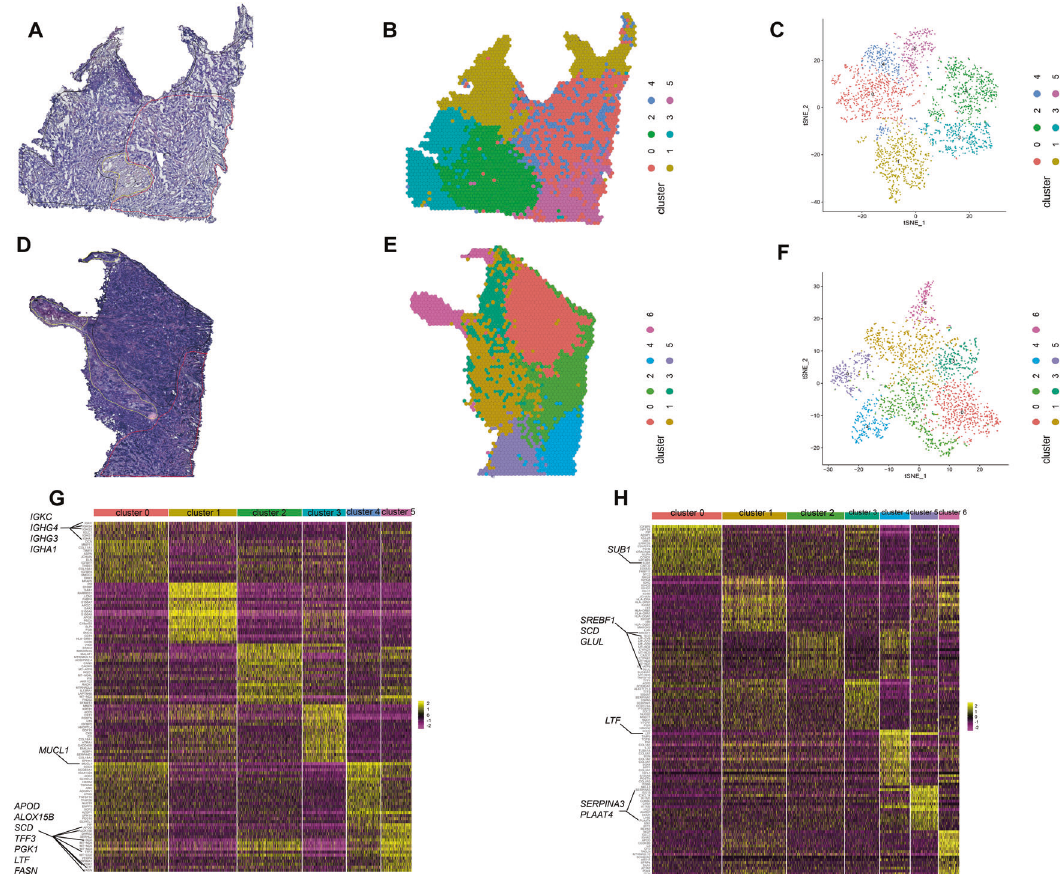
Fig. 2 Tumor morphology and hierarchical clustering results. A H&E-stained tissue images of sample 1 with marked IMPC (red), IDC-NOS and IMPC-like (black), and stroma (yellow) tissue regions. B Hierarchical clustering of the spatial features in sample 1. Each cluster was assigned a color. The cluster 0 (red) and cluster 2 (green) represent interstitial regions. The cluster 1 (yellow) represents IDC-NOS region. The cluster 3 (wathet) is IMPC-like region. Clusters 4 (blue) and 5 (pink) are the IMPC area. C t-SNE color visualization of hierarchical clustering pro fi le in sample 1. D H&E-stained tissue images of sample 4 with marked IMPC (red), IDC-NOS (black), and stroma (yellow) tissue regions. E Hierarchical clustering of the spatial features in sample 4. Each cluster was assigned a color. The cluster 0 (red) and cluster 3 (cyan) represent IDC-NOS regions. The cluster 1 (brown) and cluster 6 (pink) are stromal regions. The cluster 2 (green), 4 (blue), and 5 (purple) are the IMPC area. F t-SNE color visualization of hierarchical clustering pro fi le in sample 4. G , H Heatmap plots of sample 1 and sample 4. t-SNE, t-distributed statistical neighbor IMPC patients (Fig. 1). The clinicopathological information of the four IMPC patients is provided in Supplementary Table S3. The RNA integrity numbers (RIN) of all samples were in the range of 6.67 – 7.80 and met our requirements (Supplementary Table S4). We acquired transcriptome data for a total of 7242 spots from the four samples. In addition, 10,000 UMIs (median) and 5000 genes (median) per spot were ascertained (Supplementary Table S5). These sequencing data results were consistent with those of other published papers using ST-seq [21, 30, 31]. The numbers of genes and UMIs and the mitochondrial ratio are shown in Supplemen- tary Fig. S1. The spots with a high proportion of mitochondrial genes were fi ltered out. Next, we demultiplexed the reads and identi fi ed their spatial locations in the four tissue samples using location-speci fi c barcodes. Spatial genes expression visualization We applied PCA on highly variable expressed genes across all spots of each sample. Two methods, t-SNE [32] and UMAP [33], were used to visualize the hierarchical clustering results. Next, the clusters were classi fi ed into regions using speci fi c barcodes to generate ST maps of IMPC (Fig. 2A – F, samples 1 and 4). The maps of samples 2 and 3 are shown in Supplementary Fig. S2A – F. Different hierarchical clusters were assigned different colors,